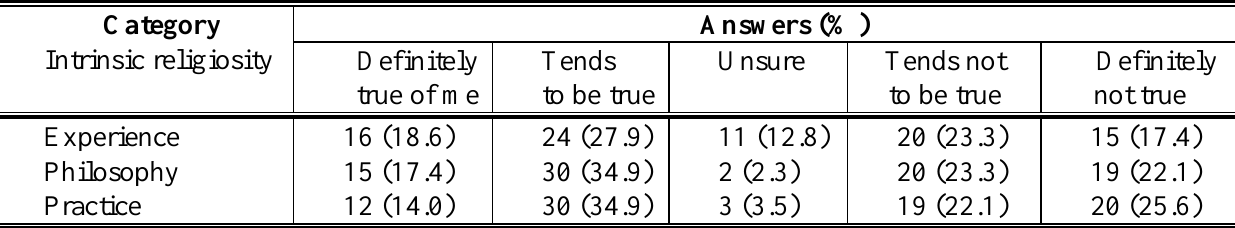
Table 1. Staff‟s intrinsic religiosity 3 ( N = 86).